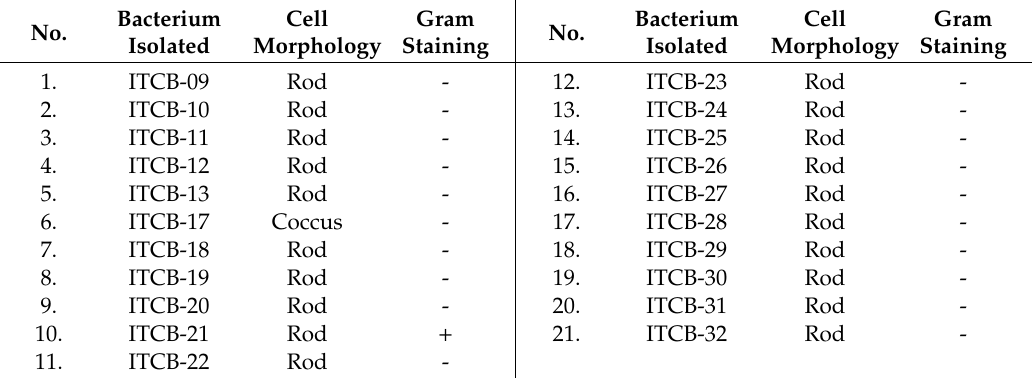
Table 2. Bacterial strains with demonstrated inorganic phosphate solubilizing activity isolate from Capsicum chinense Jacq. agroecosystems. No.